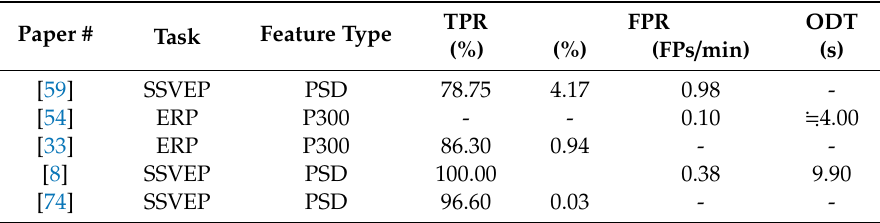
Table 4. A list of electroencephalography (EEG)-based exogenous brain-switches. PSD, power spectral